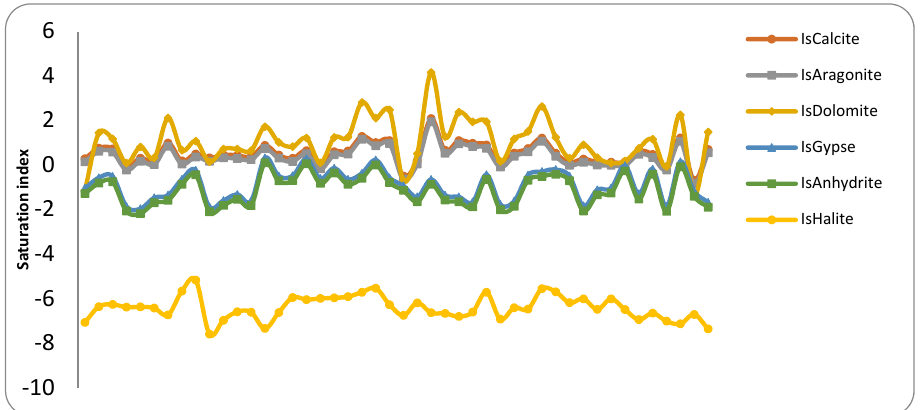
Figure 11. Variation of the different Minerals saturation indexes.